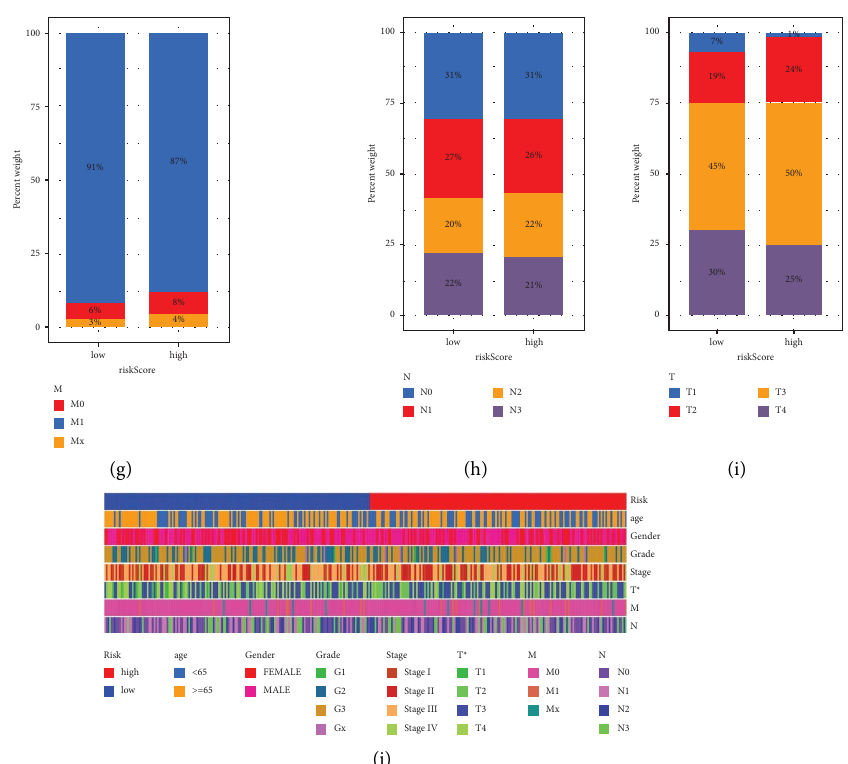
Figure 4: (a) Te nomogram was constructed by clinical characteristics and risk score; (b) the calibration curve was applied to reveal the predictive value of nomogram; (c) the time-dependent ROC curve is applied to evaluate the predictive value of prognostic prediction value; (d) the clinical correlation analysis between risk score and age; (e) the clinical correlation analysis between risk score and gender; (f) the clinical correlation analysis between risk score and grade; (g) the clinical correlation analysis between risk score and M stage; (h) the clinical correlation analysis between risk score and N stage; (i) the clinical correlation analysis between risk score and T stage; (j) the heat map demonstrated was applied to show the clinical correlation analysis between risk score and clinical characteristics of GC